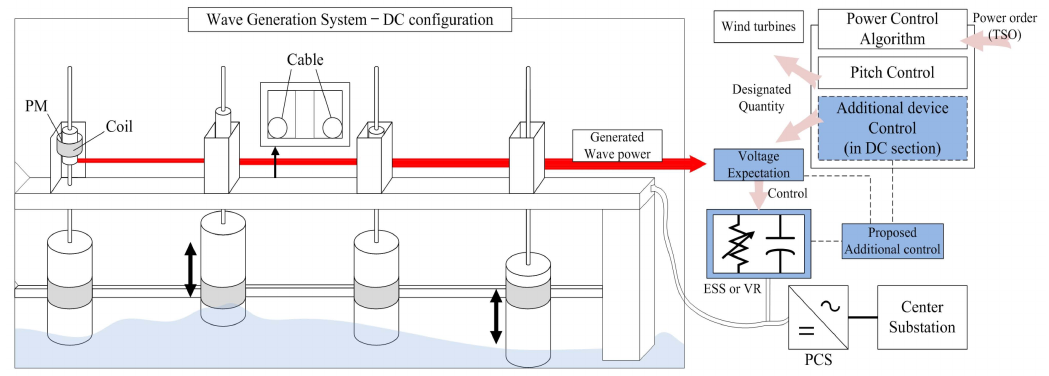
Figure 1. Applied wave generation system and the concept of the proposed power control algorithm. PM: permanent magnet; VR: variable resistance; PCS: power conversion